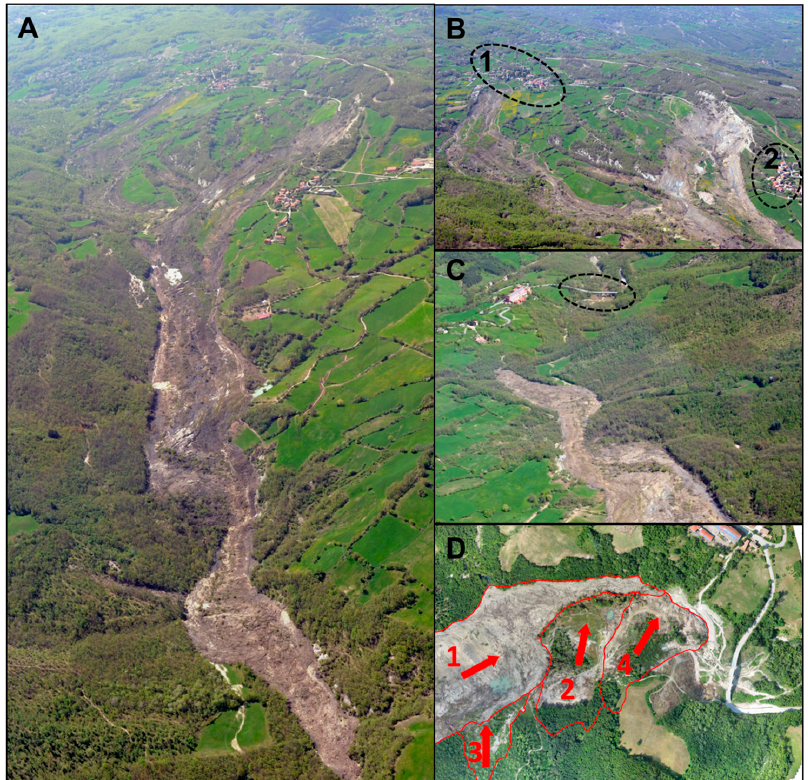
Figure 3 . 4 May 2013 Capriglio landslide aerial photographs: ( A ) landslide overview; ( B ) landslide upper sector; dashed ovals enhance the villages of Capriglio (1) and Pianestolla (2); ( C ) landslide lower sector and toe with the Antria bridge in a dashed oval. ( D ) 13 July 2013 landslide toe: secondary landslides at the toe of the main event; numbers indicate the temporal sequence of occurrences. Table 1 . The Capriglio landslide characteristics on 5 May 2013.